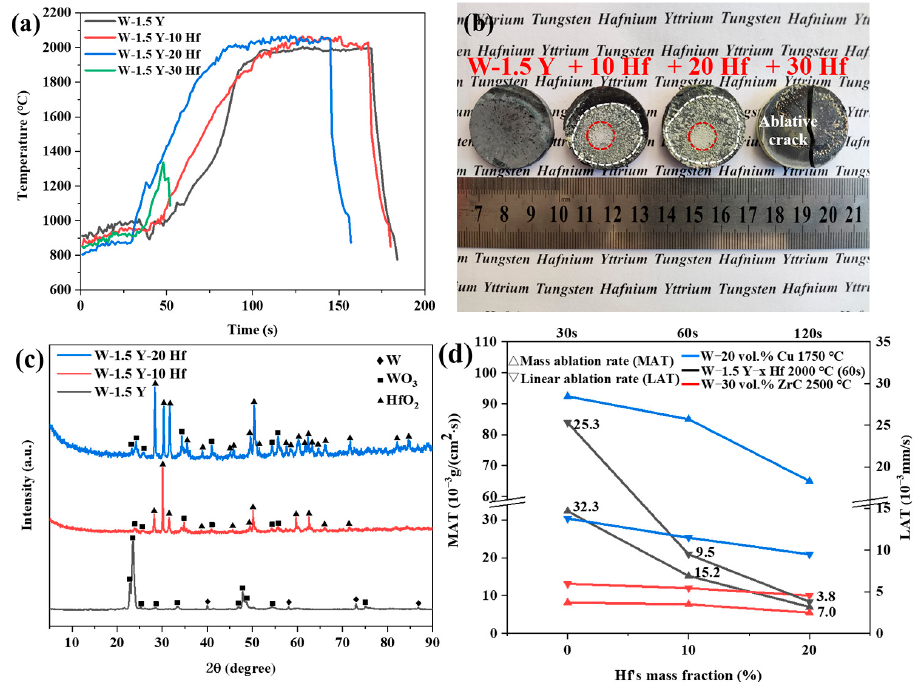
Figure 4. Analysis of the ablated surface. ( a ) Temperature versus time ablation curve. ( b ) Macromorphology of the ablated specimens. Central and surrounding areas are indicated by red and white circles, respectively. ( c ) XRD patterns of the ablated surface and ( d ) mass ablation rate and linear ablation rate.